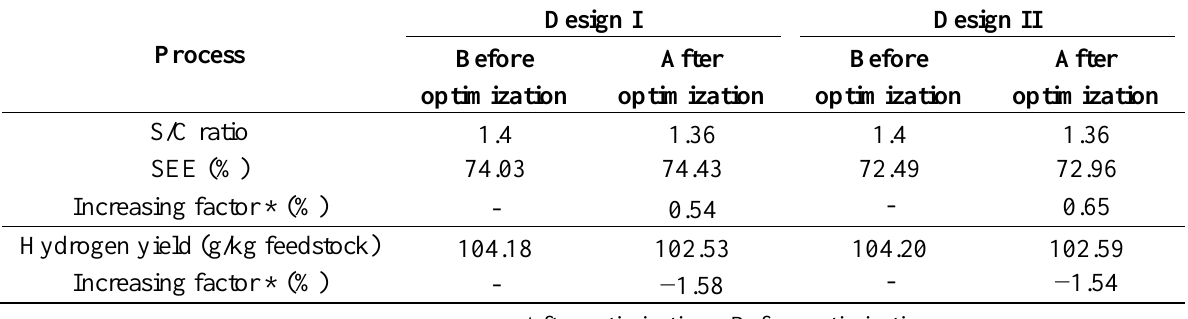
Figure 10. Optimization of SEE for the steam gasification process using torrefied oil palm. Table 7. The results of BSG process from TOP before and after